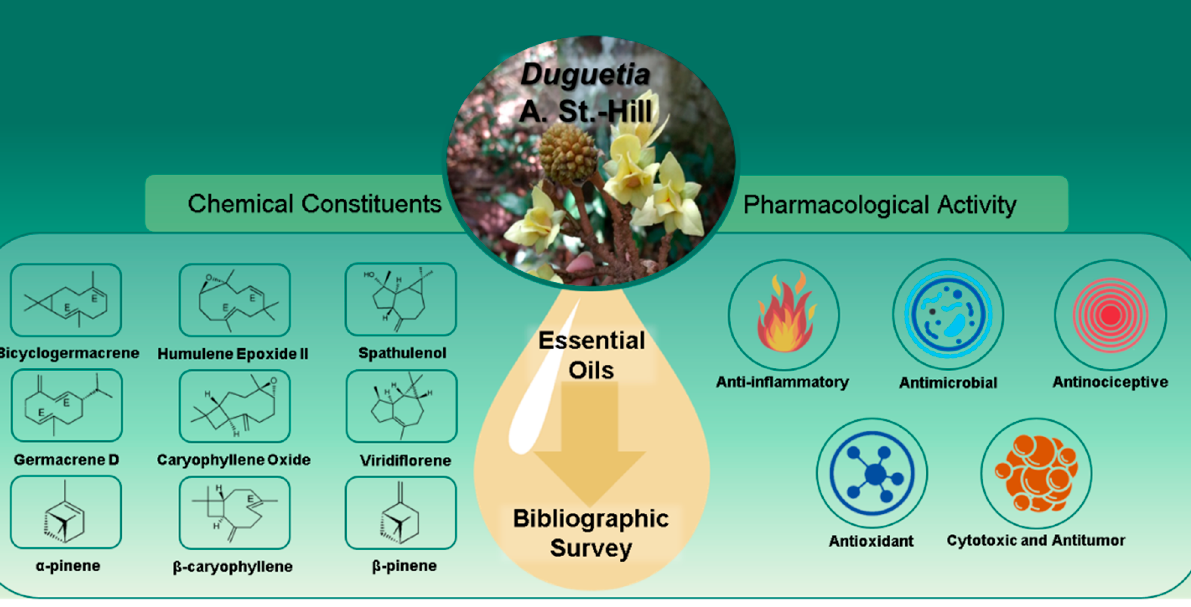
Figure 2. Main chemical composition and pharmacological properties of Duguetia